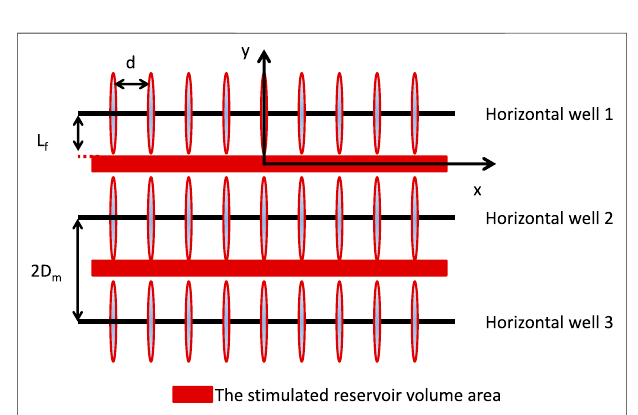
FIGURE 6 | Schematic diagram of crack tip interference.